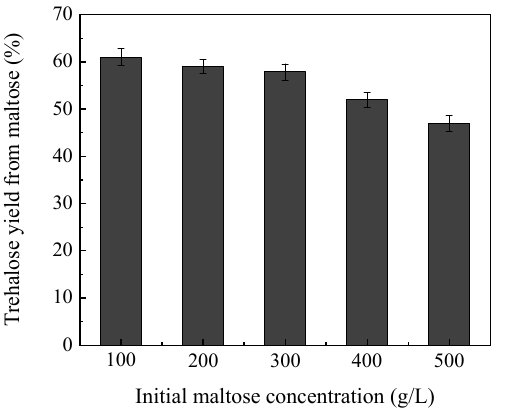
Figure 7. The yield of trehalose from maltose in the production of trehalose by whole-cell biocatalysis with different initial maltose concentrations. The error bars represent the standard deviation of three independent replicates.